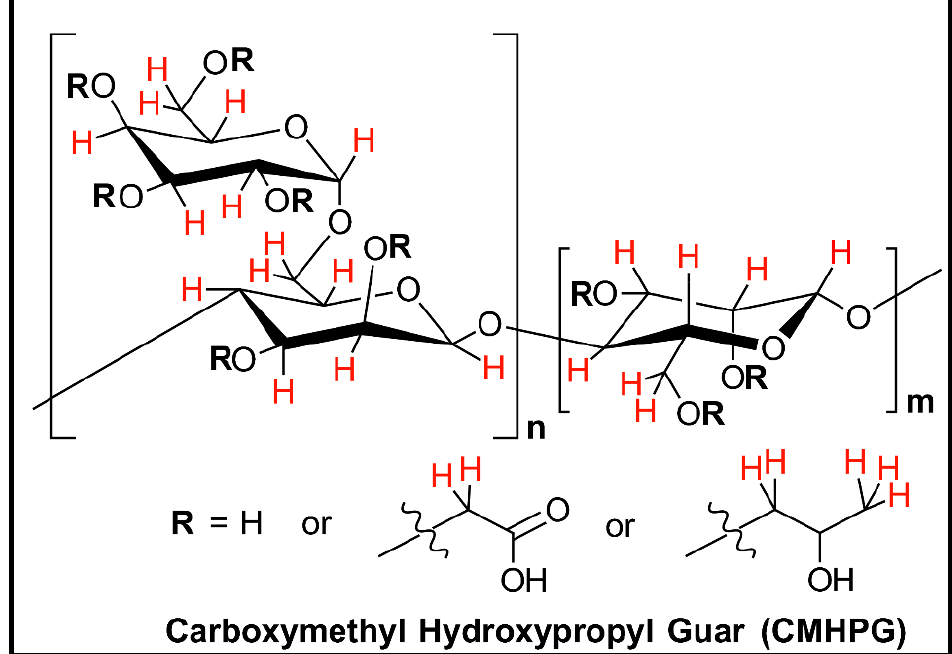
Figure 1. Hydrogenatomsinredaresitesonthepolymerthatcanbeattackedbyoxidizerradicalmolecules[48]. Figure 1. Hydrogen atoms in red are sites on the polymer that can be attacked by oxidizer radical molecules [48]. These radicals are generated at specific temperature conditions. Persulfate salts are typical ◦ ◦ low-temperature gel breakers (120 F < T < 200 F); due to high reactivity at higher temperatures, ◦ whereas bromate salts are used for higher temperature applications (T > 200 F) [49]. Unlike enzymes, the generated radicals are hard to control, limited in quantity, and will get consumed by the di ff erent additives in the fracturing fluid. They are also able to react with the tubular, causing corrosion. Acid gel breakers work in a similar manner to oxidizers; they can break the polymer molecule through hydrolysis reactions in acidic conditions resulting in a variety of insoluble materials. Acid gel breakers can also be used to de-crosslink borate-based fracturing fluids by reducing the amount of monoborate ions (MBI) in solution due to the reduction in pH